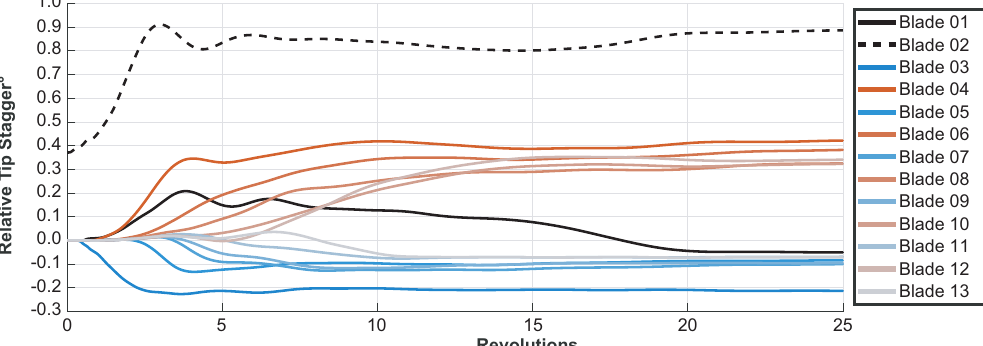
Figure 6. Fan 2’s APD behaviour shown in term of relative tip stagger history (first 13